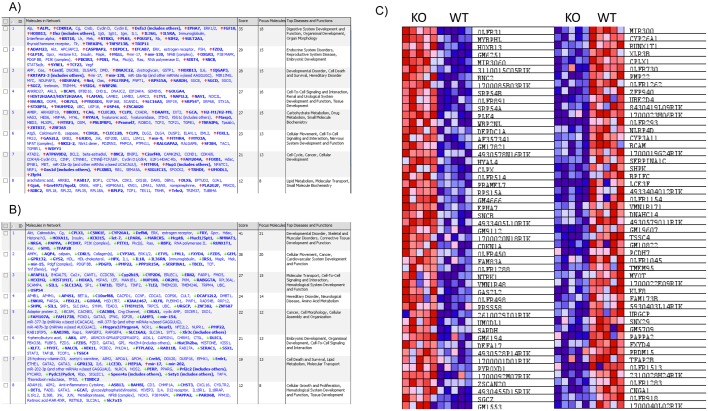
Microarray data was analyzed using Ingenuity Pathway Analysis to determine biological networks that were changed due to lack of AhR.A) Top networks affected with genes found to be up-regulated in LT-HSCs of aged AhR-KO mice relative to aged WT controls. B) Top networks affected with genes found to be down-regulated in LT-HSCs of aged AhR-KO mice relative to aged WT controls. C) Heatmap of top 50 up/down-regulated genes in LT-HSCs of aged AhR-KO mice.